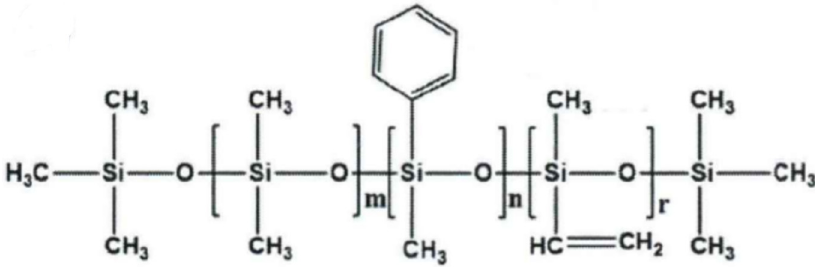
Figure 1. The structural formula of methyl vinyl phenyl silicone rubber.